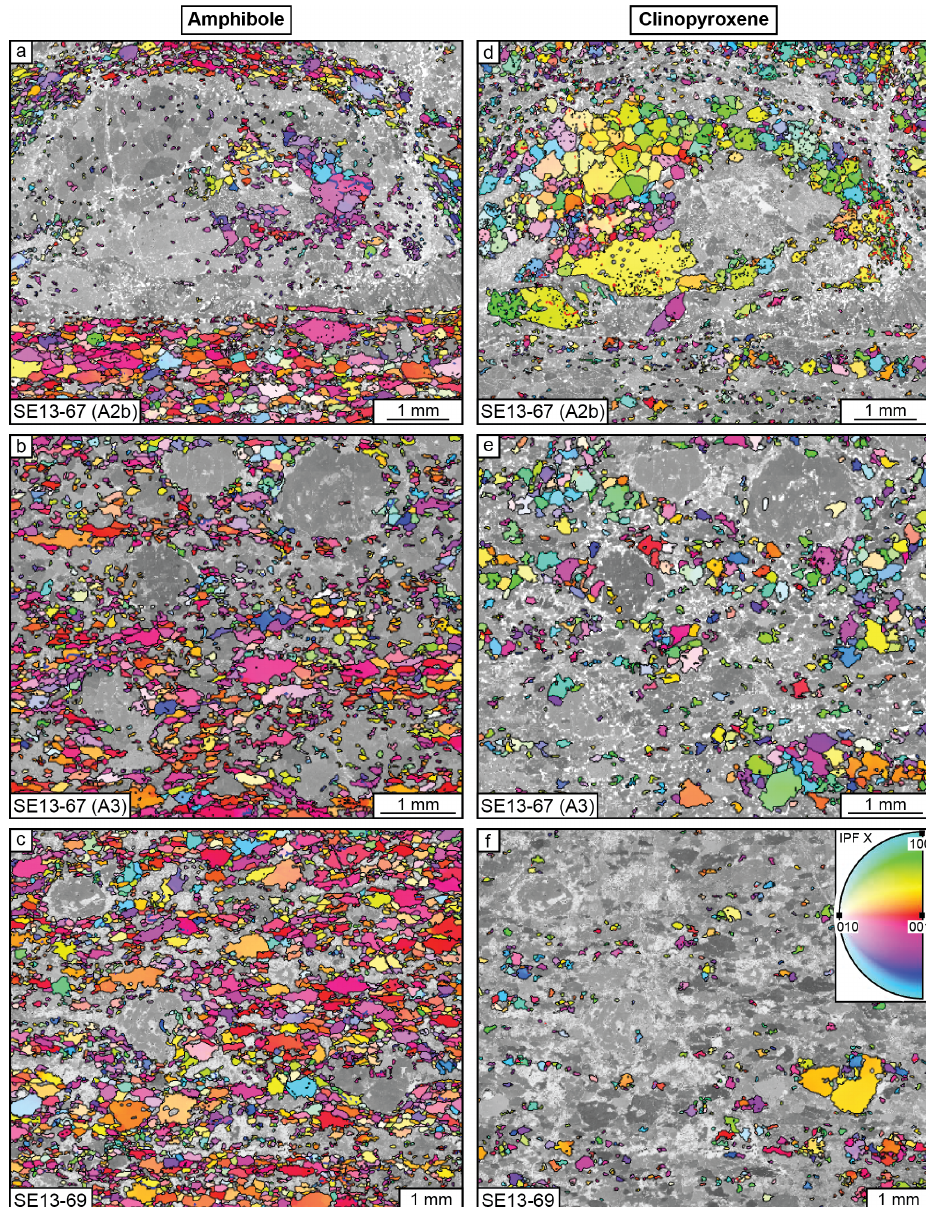
Figure 9. X direction inverse pole figure (IPF) coloring orientation maps for (a–c) amphibole and (d–f)